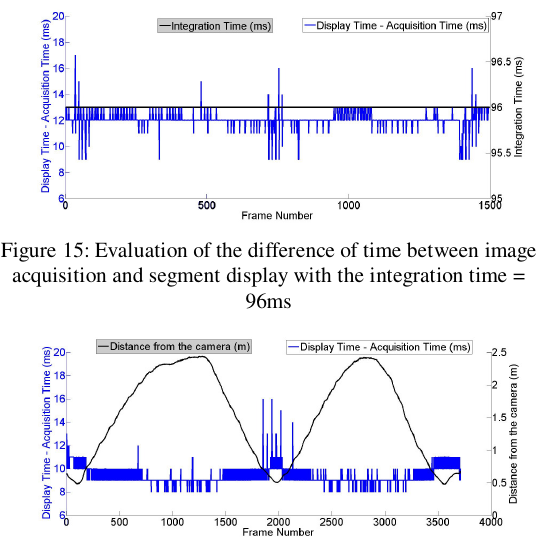
Figure 16: Evaluation of the difference of time between image acquisition and segment display while varying the distance